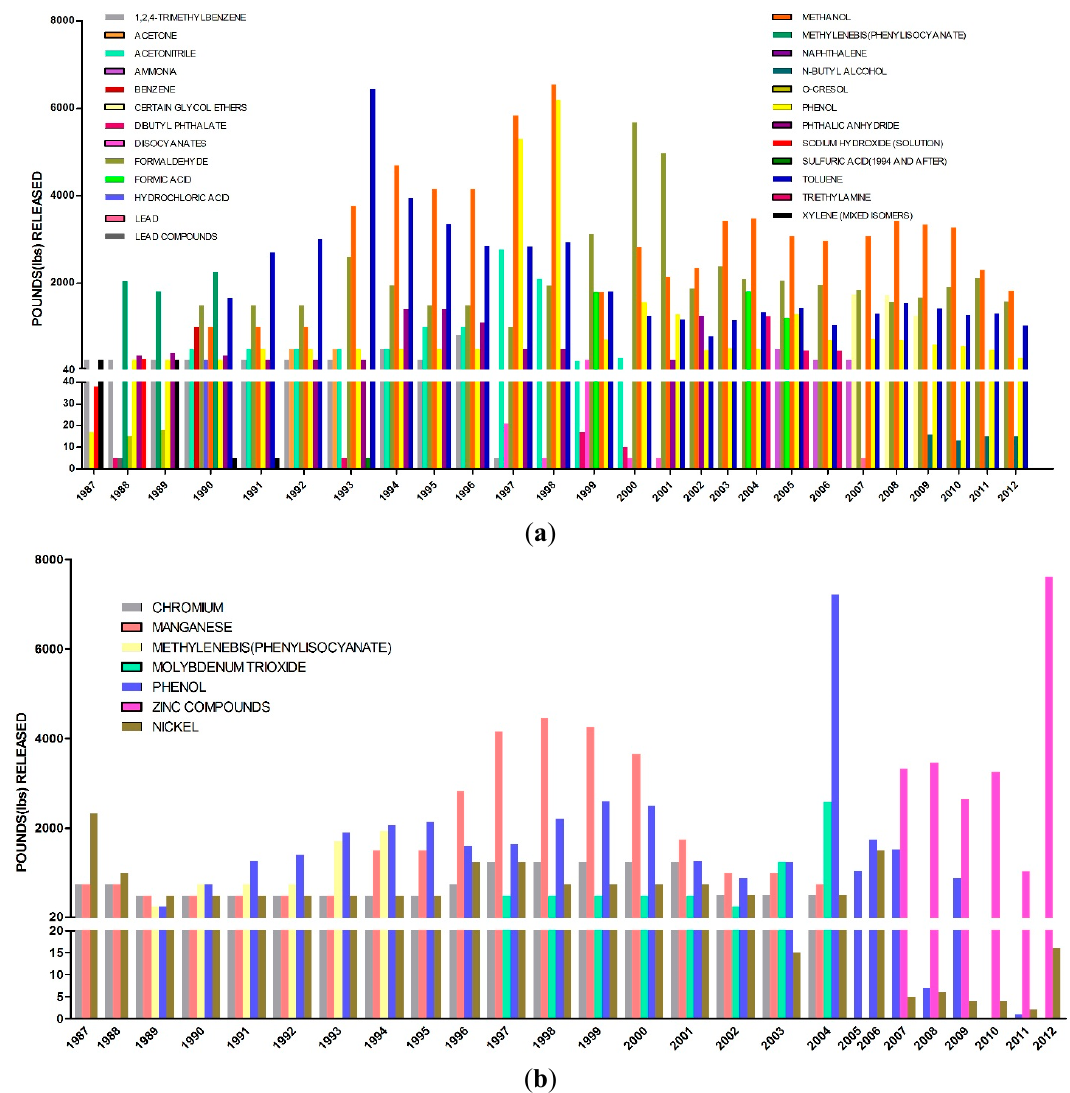
Figure 6. USEPA Toxic Release Inventory data (1987–2012) of on-site releases for ( a ) Company A and ( b ) Company B located in close proximity to the Stambaugh-Elwood Community.